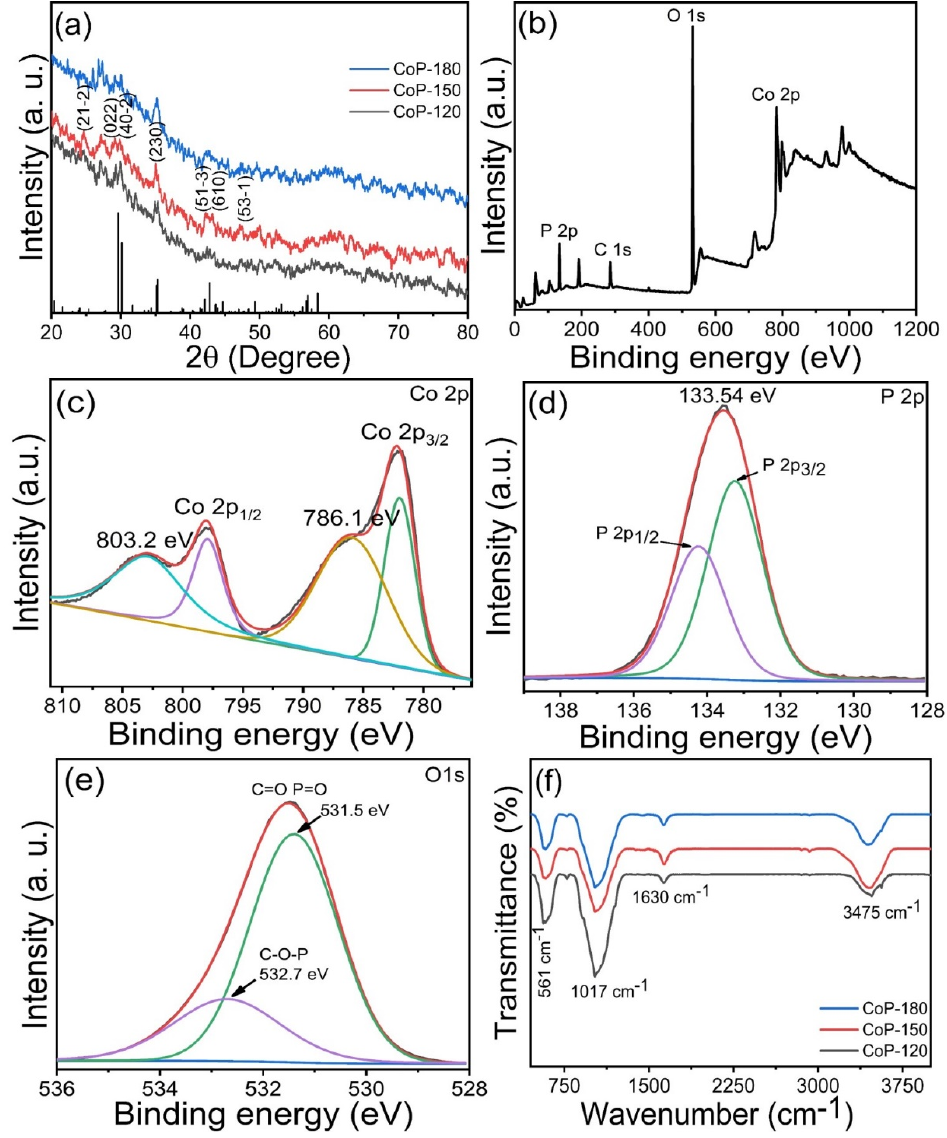
Figure 1. ( a ) XRD patterns of the Co 2 P 2 O 7 materials synthesized at various deposition temperatures of 120, 150, and 180 ◦ C, ( b ) survey spectrum of the optimized Co 2 P 2 O 7 materials at deposition temperatures of 150 ◦ C, ( c – e ) core level of the Co 2p, P 2p, and O 1s, respectively, ( f ) FT-IR spectra of the Co 2 P 2 O 7 materials synthesized at various deposition temperatures.